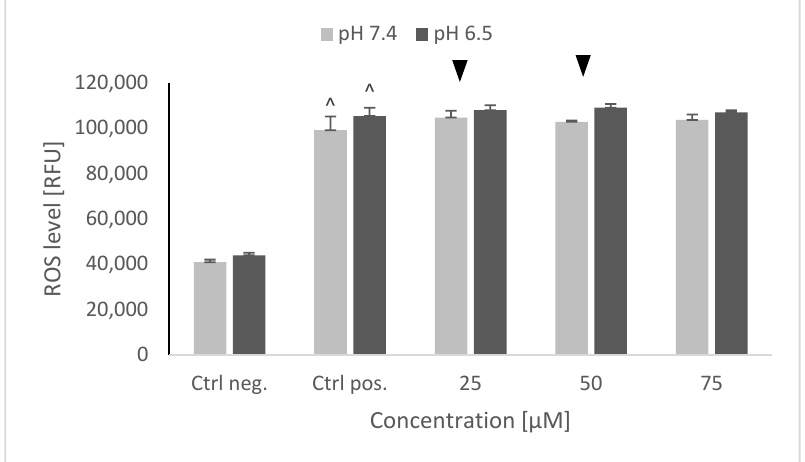
Figure 6. ROS level in SH-SY5Y cells determined using dihydroethidine (DHE) after pretreatment with NRNPs pH and exposure to 6-hydroxydopamine. The whiskers are standard deviation. ^ p ≤ 0.05, Student t -test vs. the negative control (Ctrl neg.; cells not treated with 6-OHDA), ▼ p ≤ 0.05, paired Student t -test, differences between the different pH conditions (pH 7.4 vs. pH 6.5), (Ctrl pos.; cells treated with 6-OHDA only, without any pretreatment); n = 3.